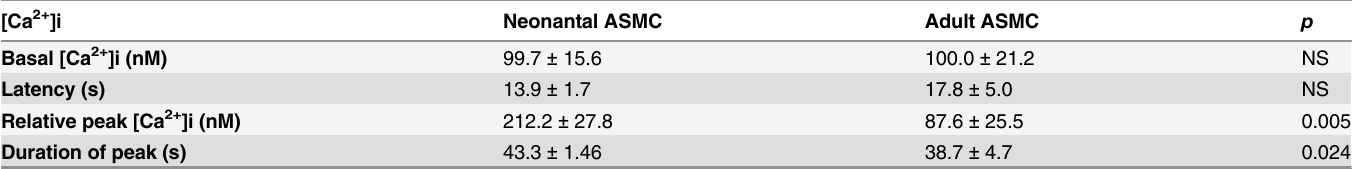
Table 2. Cytosolic calcium response to histamine (10 -5 M) on day 1 of ITS